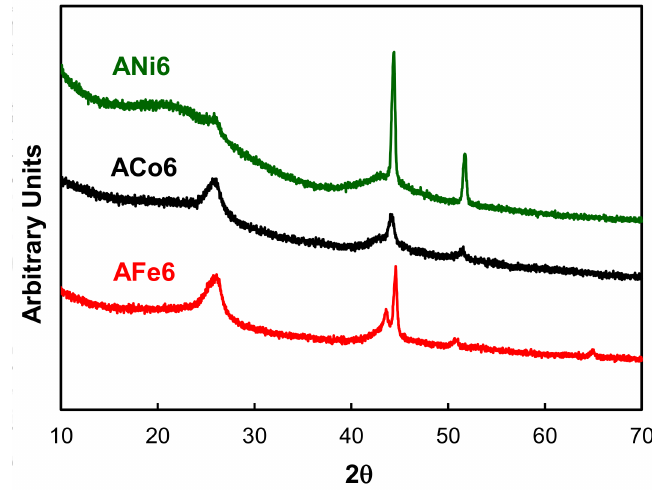
Figure 5. XRD patterns of aerogels ANi6, ACo6 and AFe6.